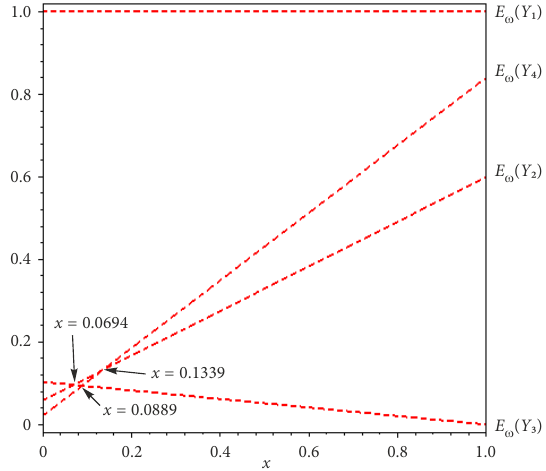
Figure 1. Decision results obtained by the